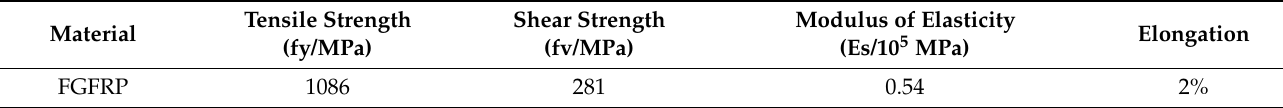
Figure 2. Experimental apparatus and test pieces: ( a ) Pull-out specimen; ( b ) Shear specimen. Table 1. Mechanical properties of the material.